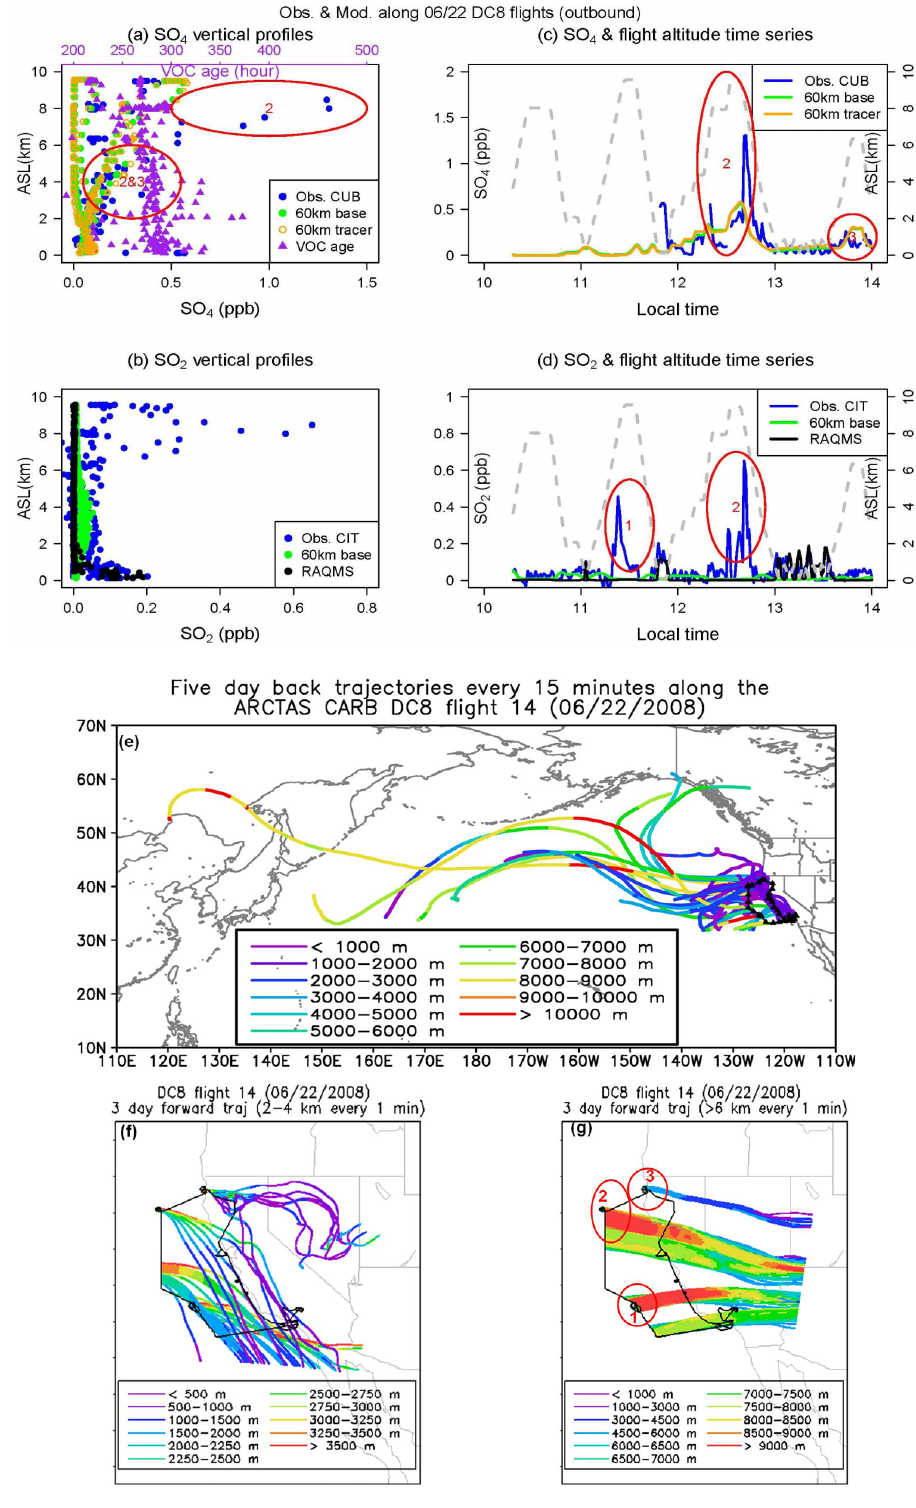
Fig. 9. Vertical profiles for (a) SO 4 (with tracer-calculated VOC age) and (b) SO 2 and time series (with flight altitudes) for (c) SO 4 and (d) SO 2 along outbound part of boundary layer flight on 22 June; (e) Back trajectories ending at the 22 June flight path (f) Three-day forward trajectories (a.s.l. 2–4km) and (g) three-day forward trajectories (a.s.l. > 6km) starting from the outbound of the 22 June flight path.